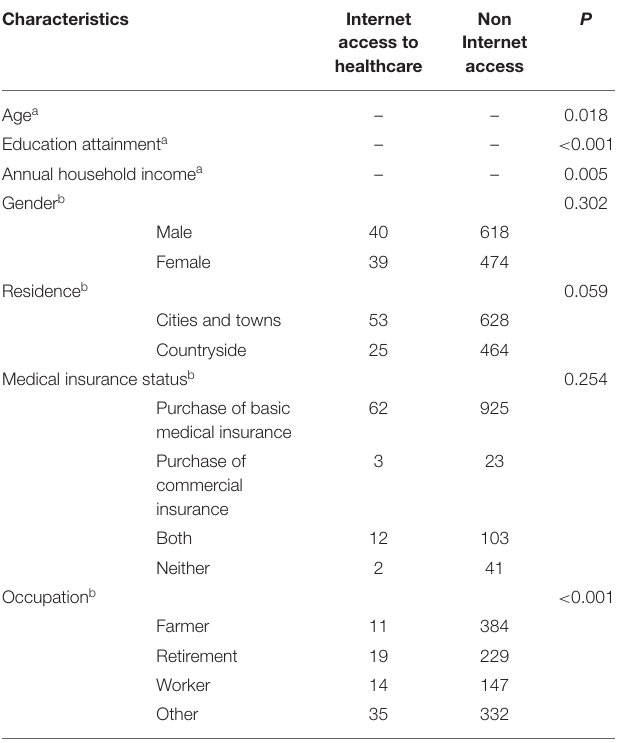
TABLE 2 | Correlation analysis of the use of internet healthcare.